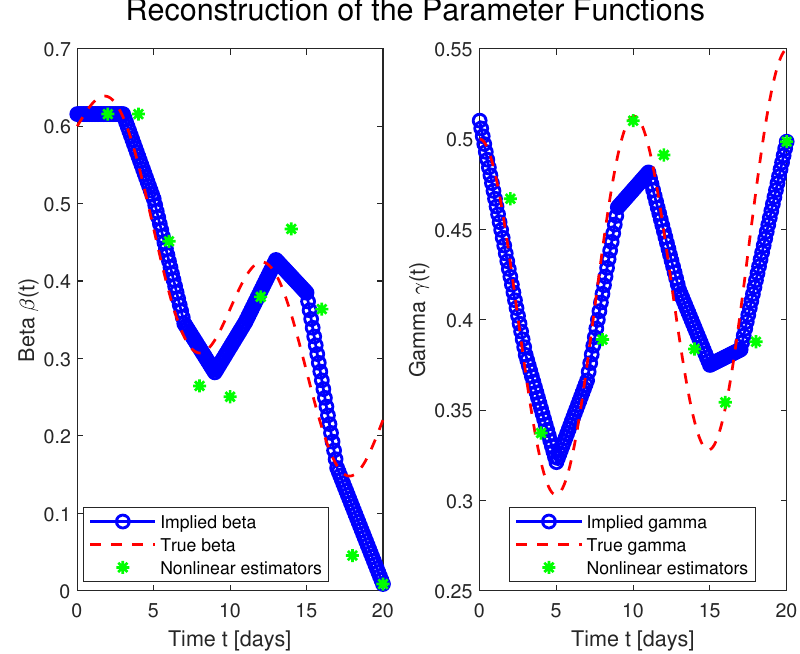
Figure 4. Recovered parameters β ( t ) and γ ( t ) with (14).